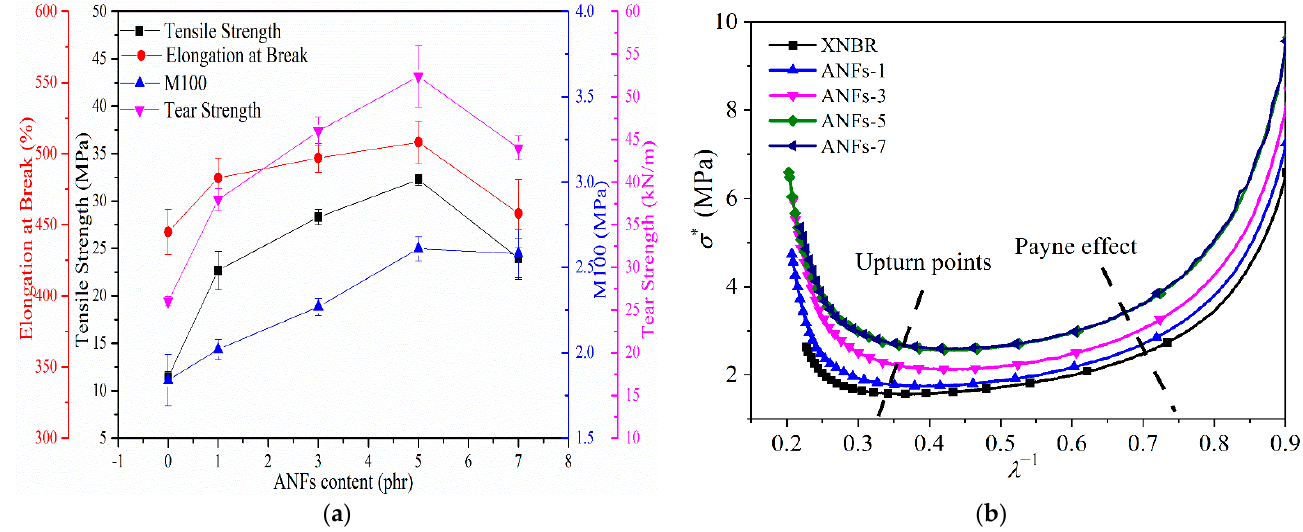
Figure 4. ( a ) Mechanical properties of ANF/XNBR nanocomposites; ( b ) Mooney–Rivlin plots of re- duced stress as a function of the reciprocal extension ratio of nanocomposites. reduced stress as a function of the reciprocal extension ratio of nanocomposites.